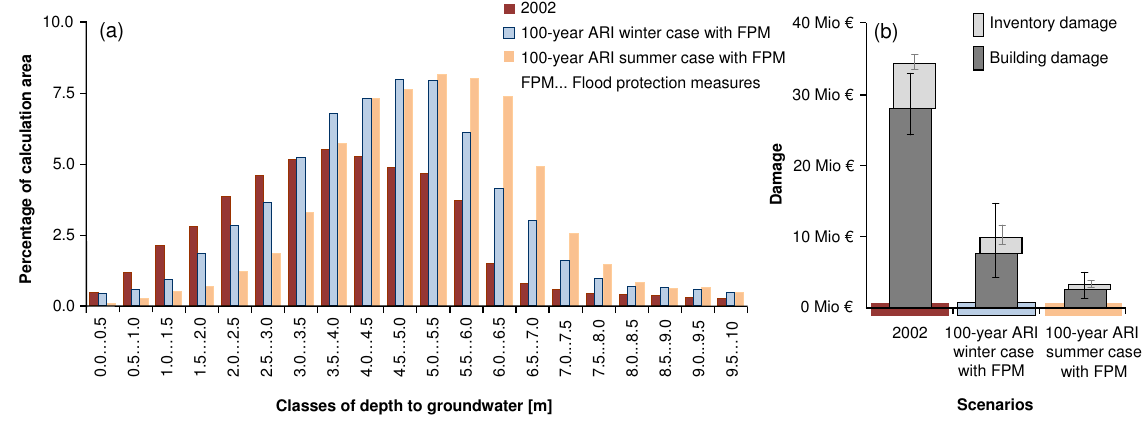
Fig. 12. Histogram of depth to groundwater classes (a) as well as overall subterranean residential damage to buildings and inventory caused by groundwater inundation for the ex-post analysis of the flood event of 2002 and the ex-ante analysis of winter and summer flood events with flood protection measures (b)